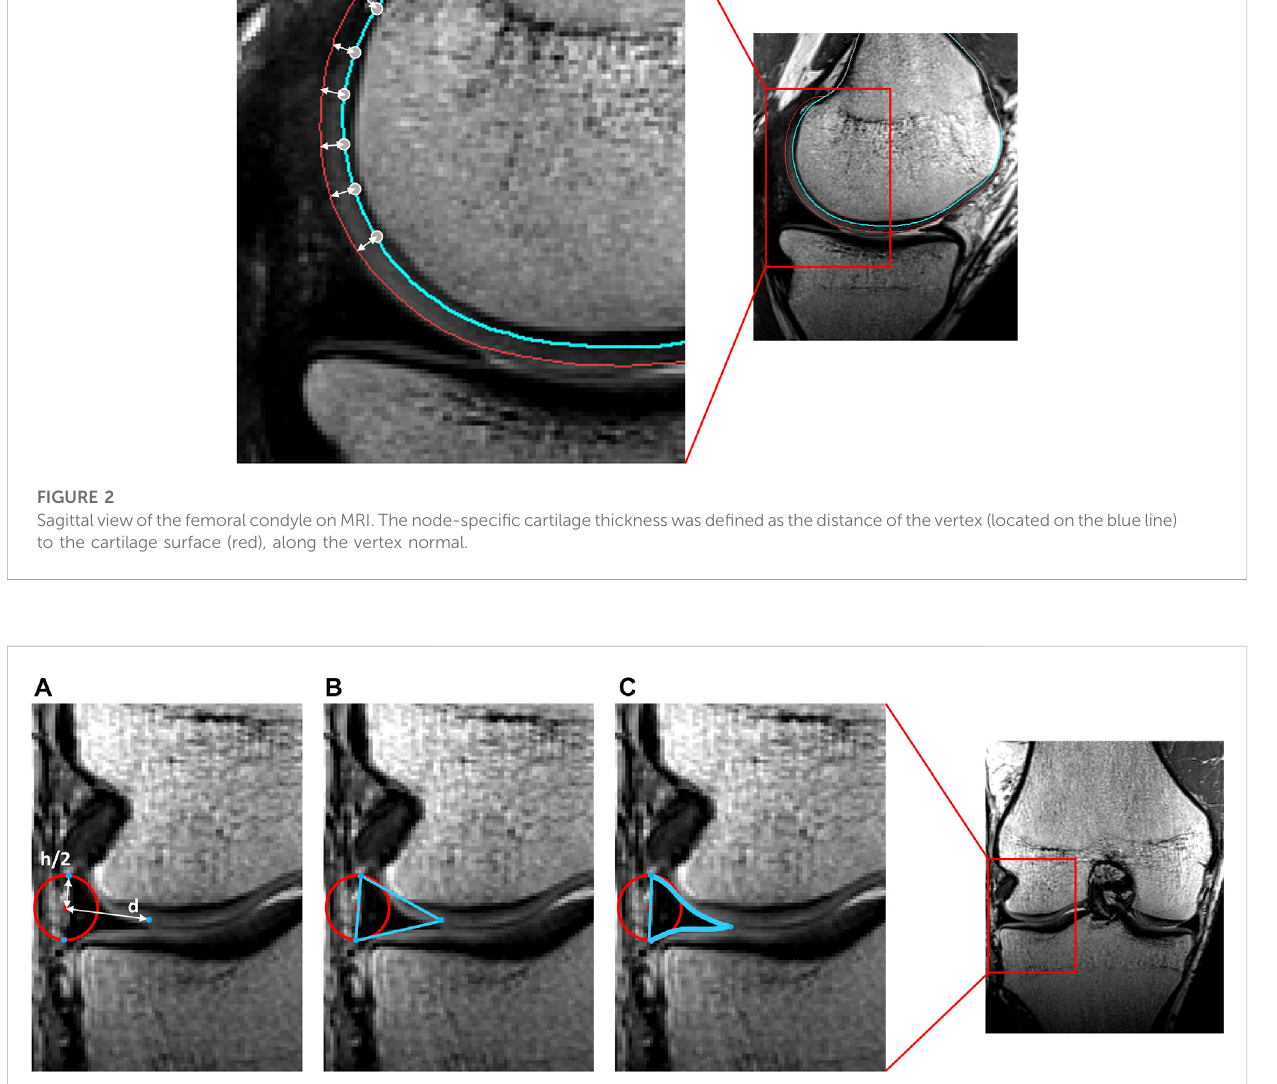
FIGURE 3 Representation of meniscal modeling. (A) A tube was wrapped elastically from the anterior to the posterior horn enforcing an offset of half the meniscal height (h/2). A varying distance (d) is extracted for every node. (B) Triangles are formed by interconnecting the three points per node. (C) Following correction for local penetration, the edges of the meniscus adapt to fi t in between cartilage